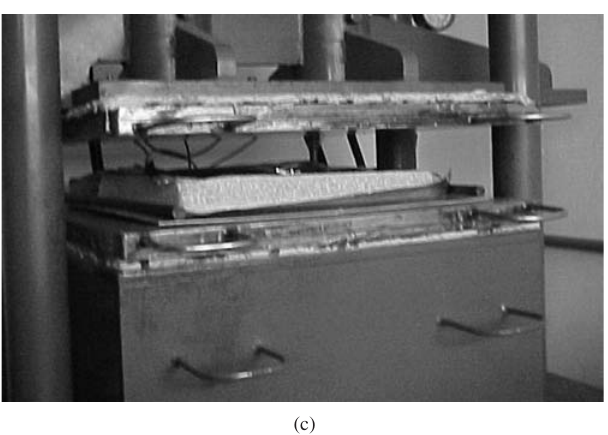
Figure 1. Production stages of the particleboards: a) interior of the gluer – mixture of wood particles with the adhesive and the paraffin; b) mattress; and c) preparation for the